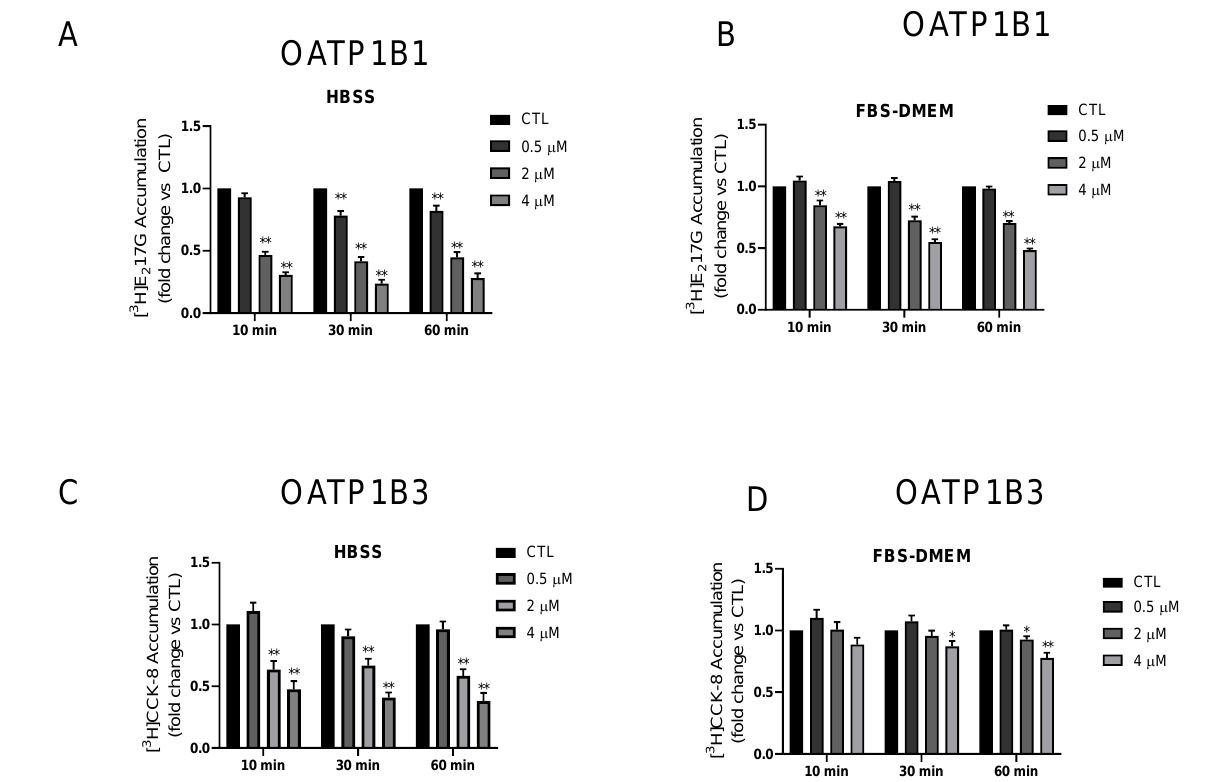
Figure 1. Effects of preincubation with nicardipine in HBSS buffer or FBS-containing medium on OATP1B1- and OATP1B3-mediated transport. Model-estimated fold changes and associated SE of the accumulation of [ 3 H]-E 2 17 β G (1 µ M, 2 min) ( A , B ) and [ 3 H]-CCK-8 (1 µ M, 3 min) ( C , D ) vs. control (CTL) in HEK293-FLAG-OATP1B1 and HEK293-FLAG-OATP1B3 cells after preincubation with 0.5, 2, and 4 µ M nicardipine for 10 min, 30 min, and 1 h in HBSS buffer or FBS-containing medium, as indicated in the legend. Substrate accumulation was determined in the absence of nicardipine after washing. Linear mixed-effects models were fit to the data, as described in the “Materials and Methods” ( n = 3 in triplicate). * and ** indicate statistically significant differences vs. CTL with Bonferroni-adjusted p -values < 0.05 and 0.01,